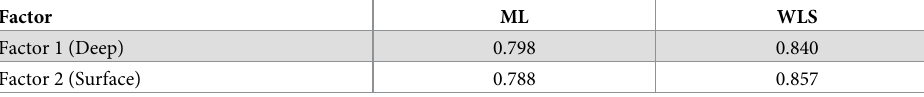
Table 9. Coefficient omega reliability